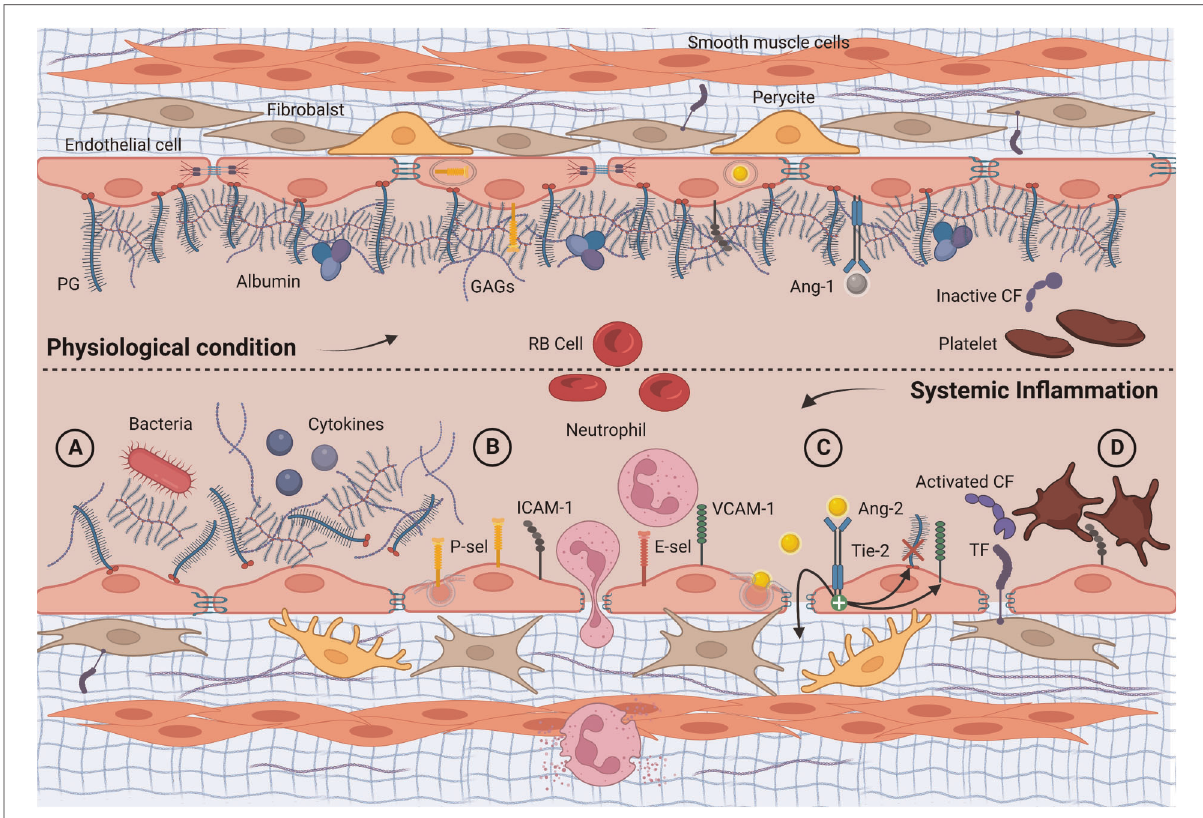
FIGURE 1 Longitudinal section of a blood vessel: endothelial phenotype in physiological conditions and infectious/in fl ammatory endotype. ( A ) Acute glycocalyx shedding following endogenous and/or exogenous proin fl ammatory stimuli; ( B ) unveiling and overexpression of membrane glycoproteins, adhesion, and diapedesis of neutrophils; ( C ) Ang-2 exocytosis with increased vascular leakage, further glycocalyx shedding via heparanase and up-regulation of adhesion molecules; ( D ) subendothelial TF exposure, activation, and consumption of clotting factors and platelets. Ang-1, angiopoietin 1; Ang-2, angiopoietin 2; CF, clotting factor; E-sel, E-selectin; GAGs, glycosaminoglycans; PG, proteoglycan; P-sel, P-selectin; RB cell, red blood cell; TF, tissue factor; Tie-2, tyrosine kinase receptor. Created with